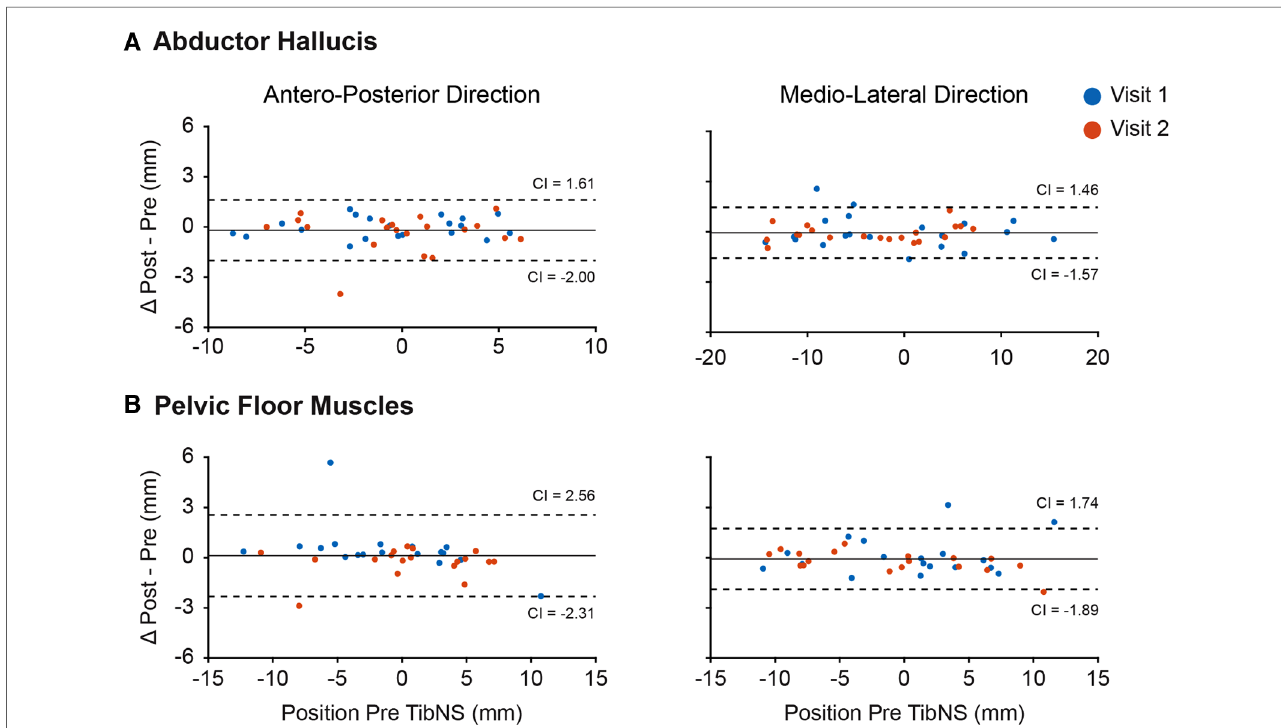
FIGURE 3 Bland-Altman plot of coil position in antero-posterior and medio-lateral planes during TMS assessment of abductor hallucis ( A ) and pelvic fl oor muscles ( B ). Each point represents the difference for one participant. The dashed lines represent the 95% con fi dence intervals (CI), the solid line represents the mean difference of all